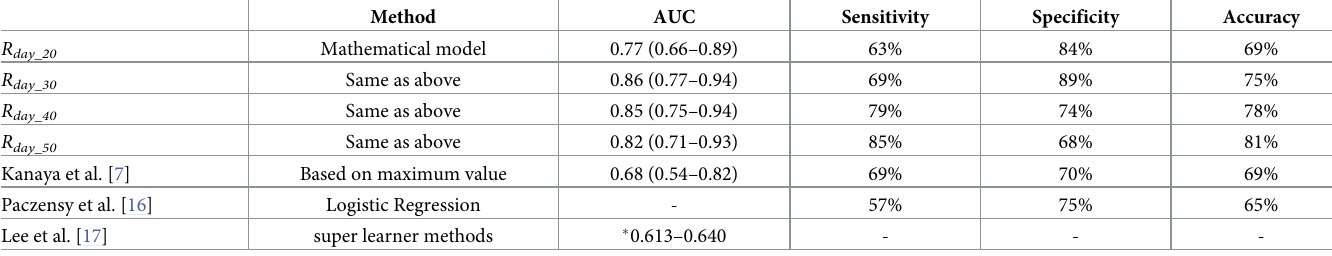
Table 4. Assessment of R by using receiver operating characteristics day_n